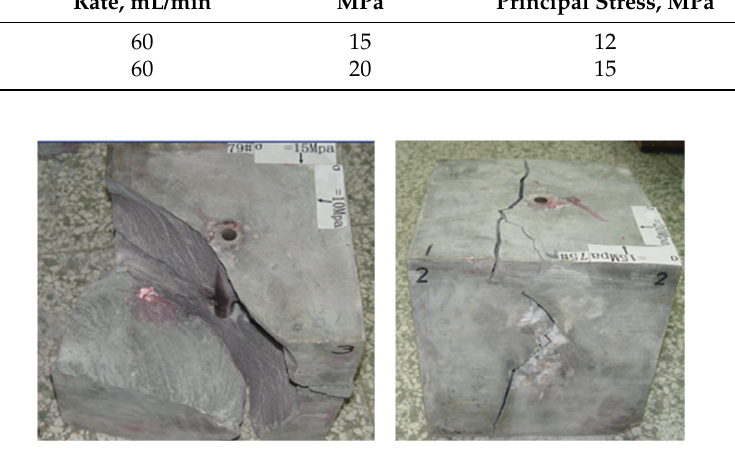
Table 2. Different parameters in fracturing experiments.